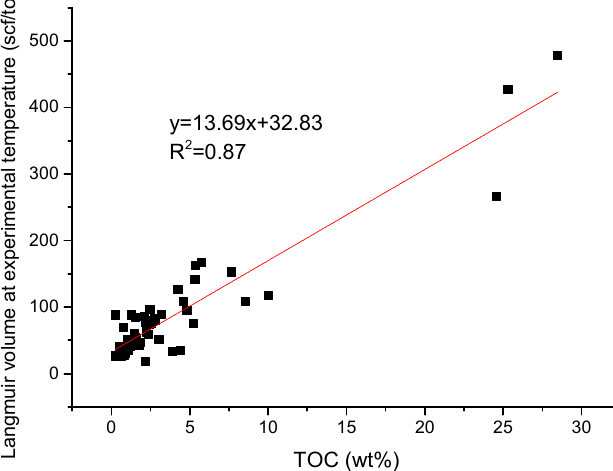
Figure 1. The relationship between the TOC and Langmuir volume at experimental temperature (30 °C) for the studied shale samples.